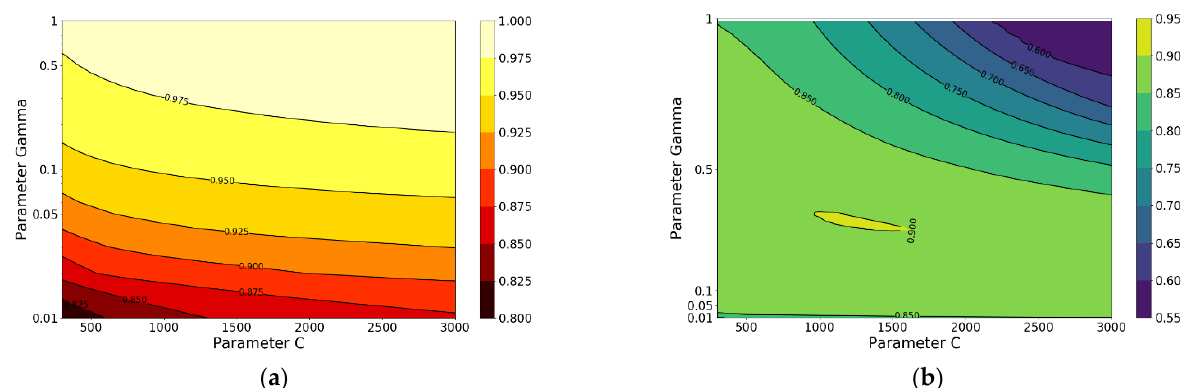
Figure 5. R-square of SVR under different hyperparameters C and γ on ( a ) training set and ( b ) test set.